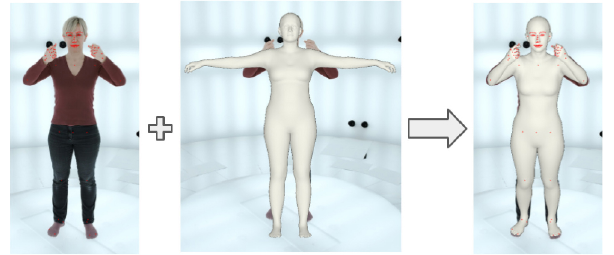
Fig. 2 Reprojection loss: input image with OpenPose keypoints marked in red (left), SMPL-X model in initial rest-pose (middle), and pose and shape adapted SMPL-X model based on the OpenPose keypoints (right).